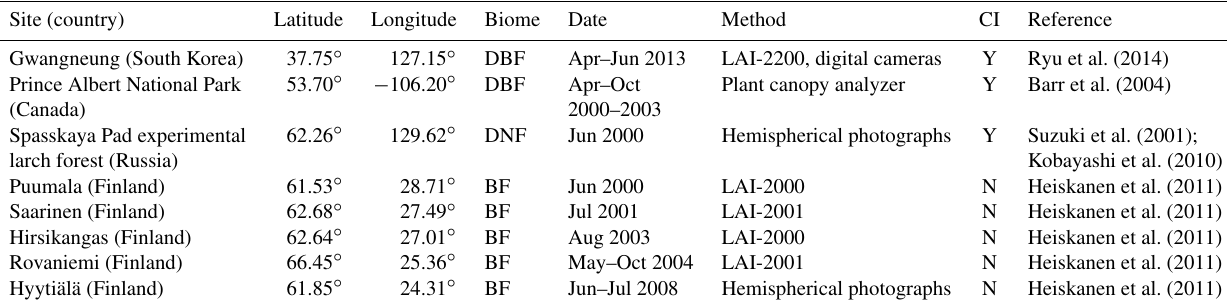
Table 1. Summary of field LAI measurements used for validation with the derived forest overstory and understory LAI. Site (country)